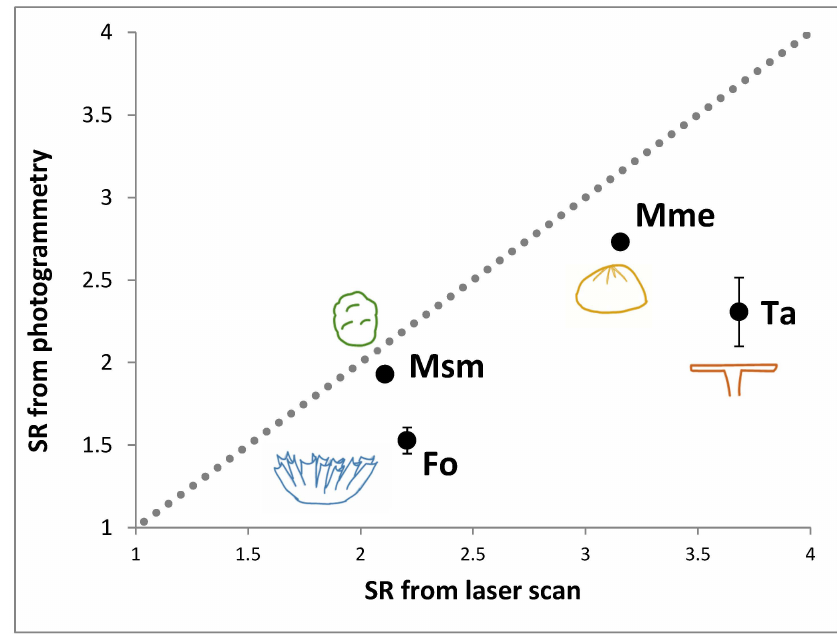
Figure 5. Comparison of the surface rugosity (SR) values derived from 3D models determined from laser scanning with the average (+/ ´ SD) SR from all replicate models determined from photogrammetry for four coral morphotypes. Dashed line is 1:1, points under this line indicate where SR is underestimated by photogrammetry. Morphologies are: Fo, Foliose; Mme, Massive-medium; Msm, Massive-small; Ta, Tabulate.